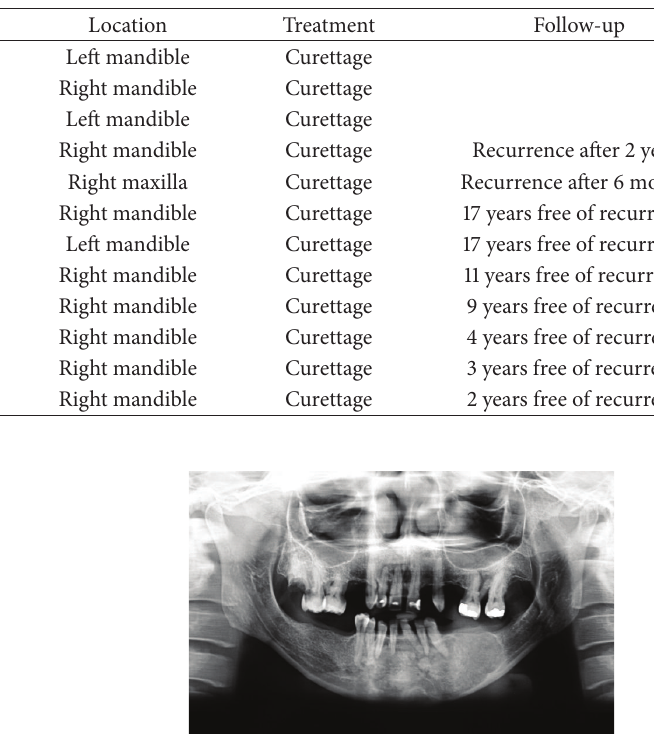
Table 1: Characteristics of the cases treated by curettage reported in the literature.